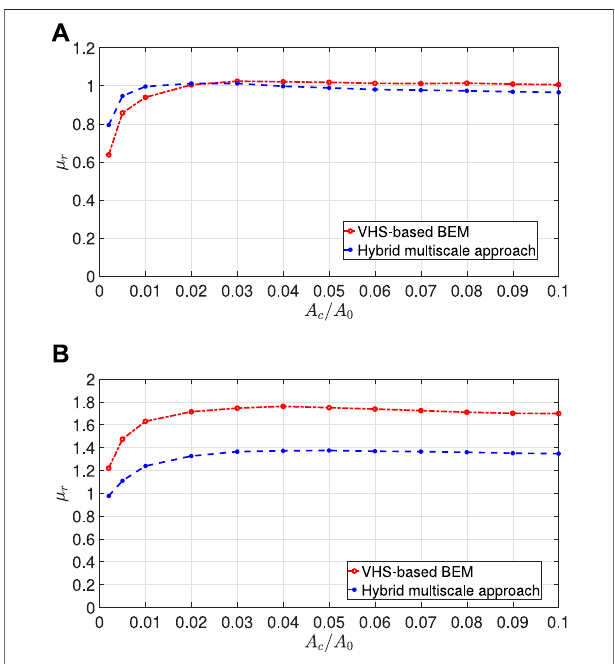
FIGURE 9 | Friction coef fi cient as a function of the normalized contact area at a velocity of (A) 10 [mm/s], (B) 50 [mm/s].